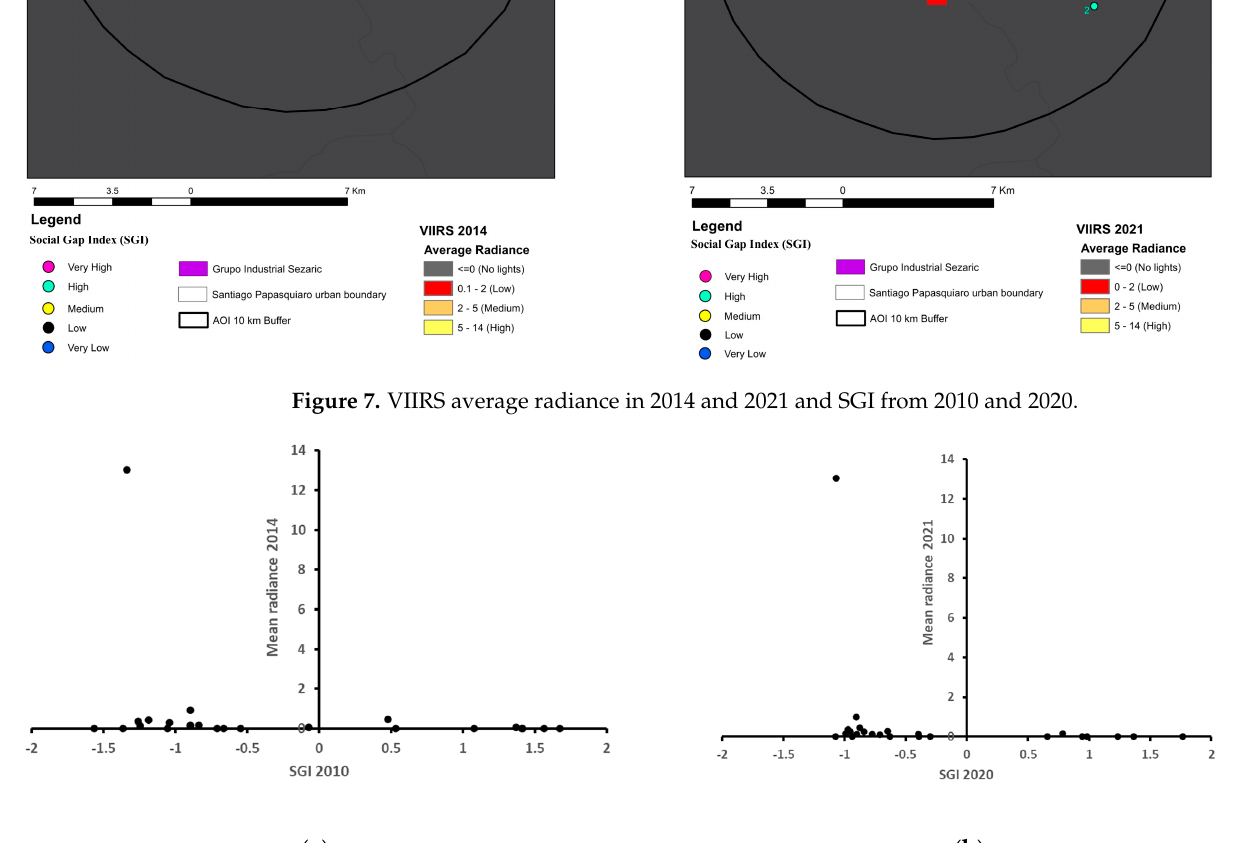
Figure 8. Average radiance plotted against SGI for the 24 locations in Table S5. ( a ) Radiance for 2014 and SGI for 2010 and ( b ) radiance for 2021 and SGI for 2020 Table 5. Descriptive statistics of radiance in relation to SGI categories.